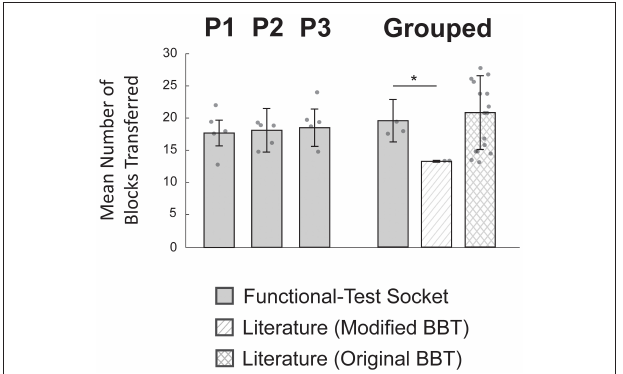
FIGURE 5 | Modified box and blocks test (BBT) performance was similar to literature values. Individual participants (P1-P3) moved similar numbers of blocks across trials ( N = 5 per bar). Individual performance was not statistically evaluated as the inter-subject variation was relatively small. In the grouped case, performance with the functional-test socket ( N = 3) was not statistically different from values reported with the original BBT ( N = 17). However, the grouped functional-test socket results did differ significantly compared to reported values for the modified BBT ( N = 2). * p -value < 0.025, two-sample t -test corrected for multiple comparisons; individual data points are overlayed on each